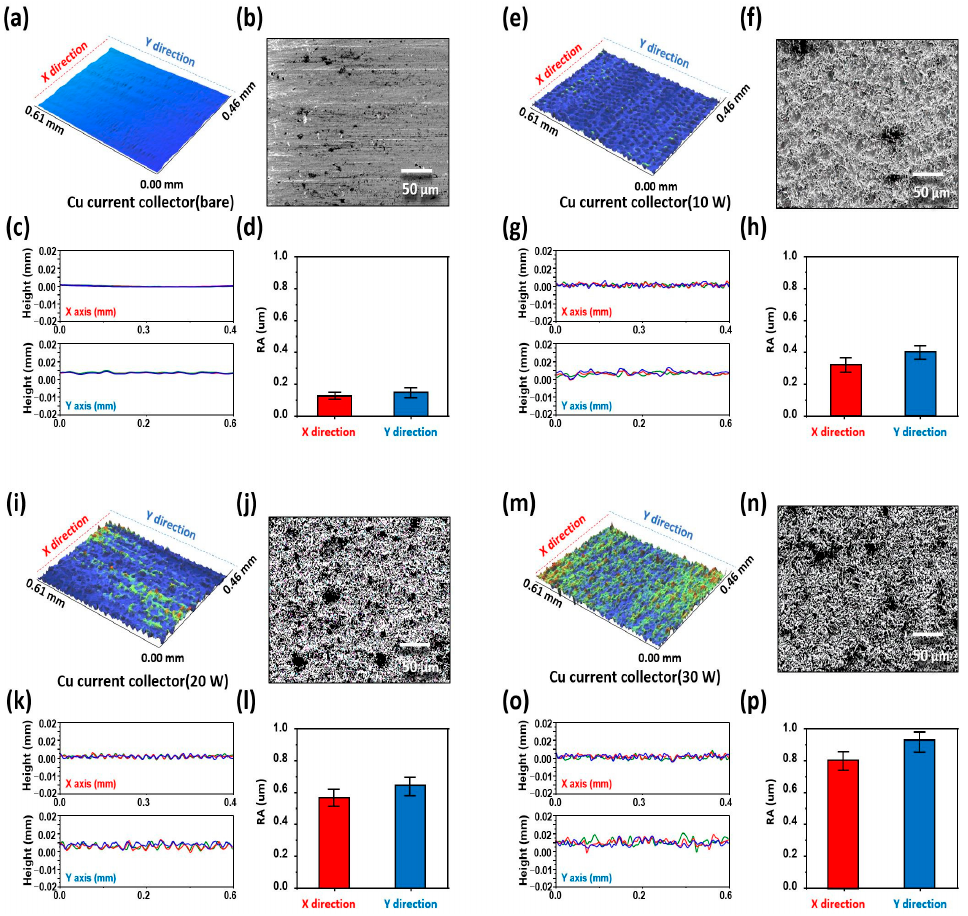
Figure 2. Fabrication of a bio-inspired Si electrode. The bare Cu current-collector: ( a ) Three-dimensional (3D) image; ( b ) SEM images; ( c ) line scan profiles in the X and Y directions; and ( d ) surface roughness averages (R a ) measured in (c); the Cu current-collector after the one-step method by the 10 W power laser process: ( e ) 3D image taken by surface profiler; ( f ) SEM images; ( g ) line scan profiles in the X and Y directions; and ( h ) surface roughness averages (R a ) measured in (g); the Cu current-collector after the one-step method by the 20 W power laser process: ( i ) 3D image taken by surface profiler; ( j ) SEM images; ( k ) line scan profiles in the X and Y directions; and ( l ) surface roughness averages (R a ) measured in (k); the Cu current-collector after the one-step method by the 30 W power laser process: ( m ) 3D image taken by surface profiler; ( n ) SEM images; ( o ) line scan profiles in the X and Y directions; and ( p ) surface roughness averages (R a ) measured in (o).